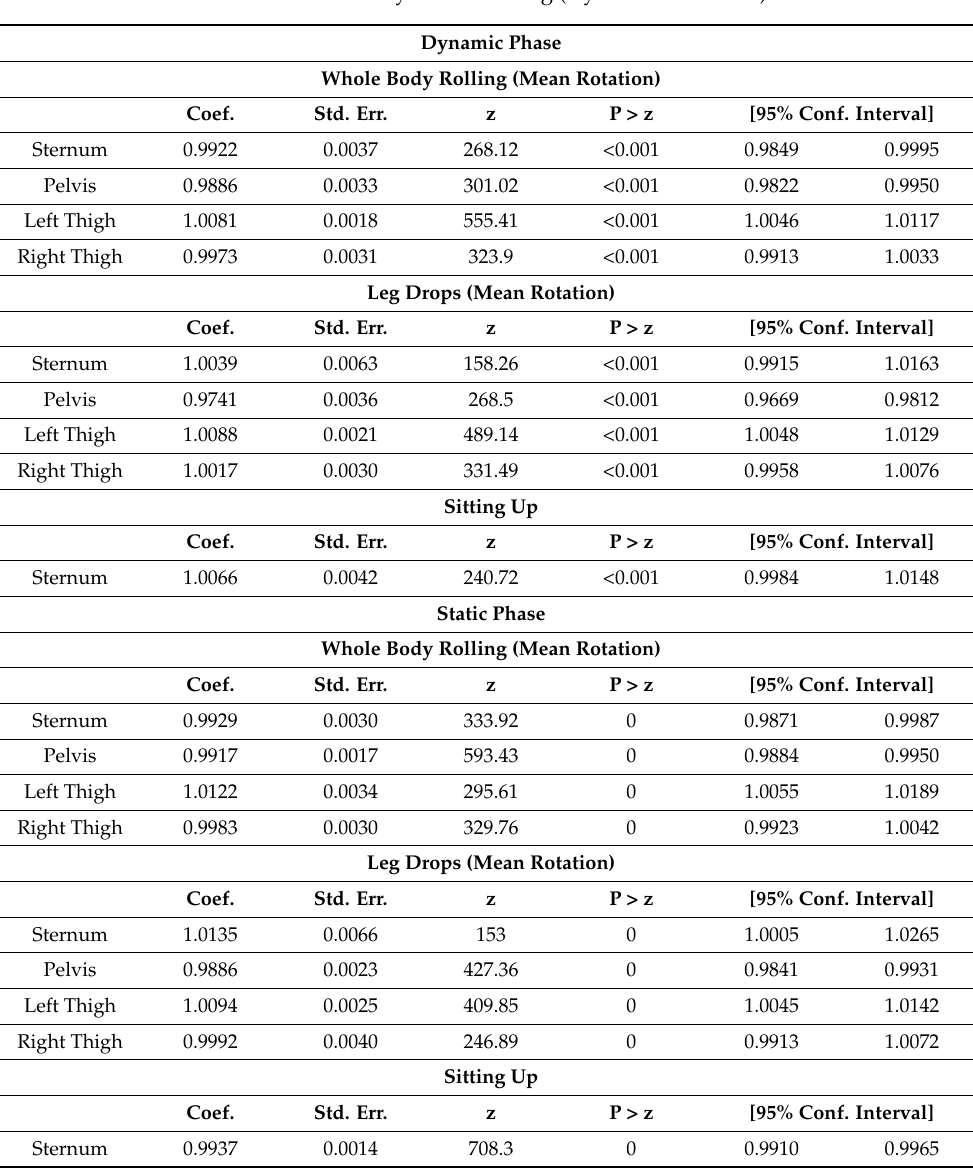
Table 4. Results of VICON Motion Analysis Lab Testing (Dynamic and